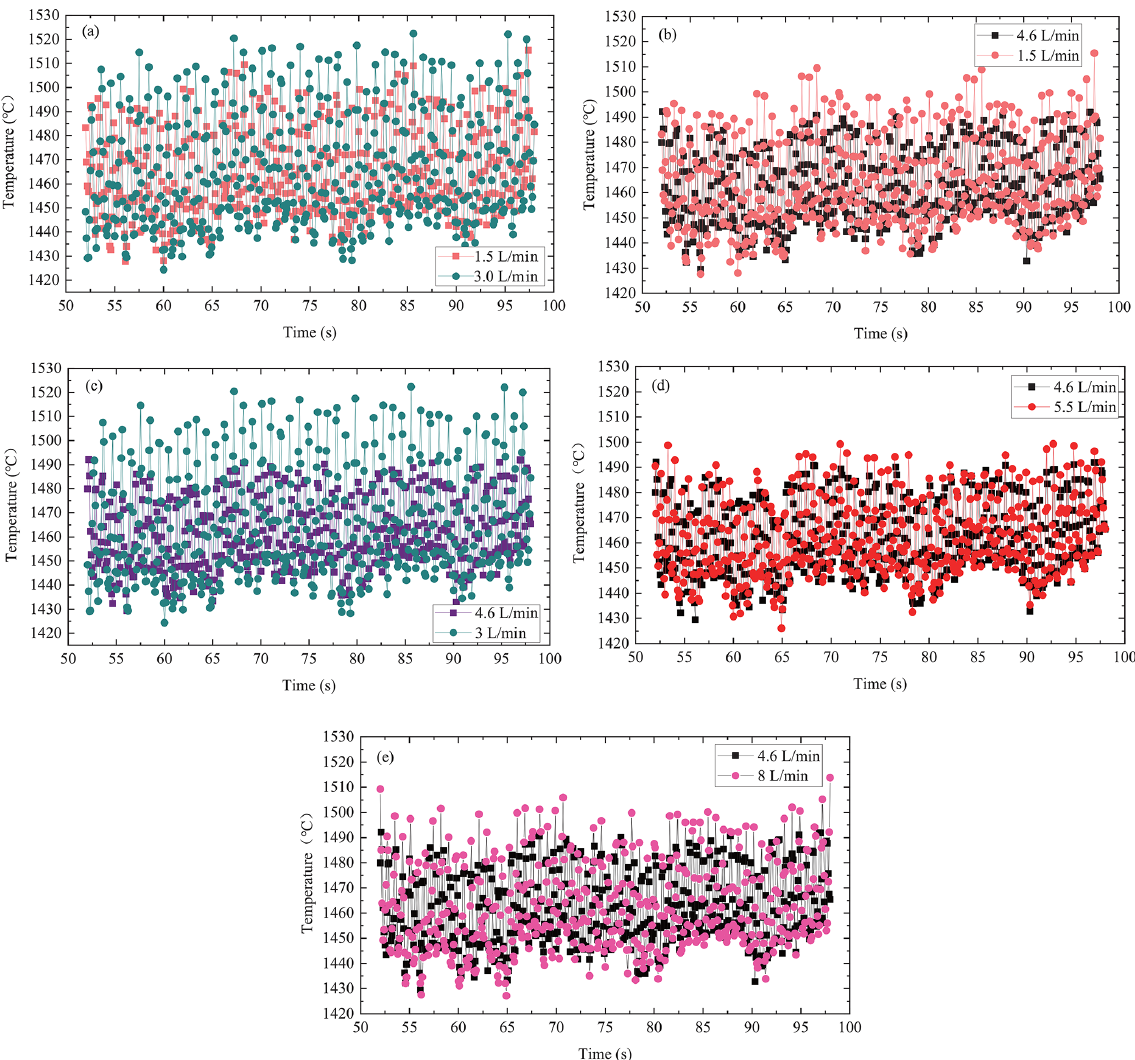
Figure 13. Temperature comparison of the welding of the micro-section at different flow rates. Table 2. The chemical composition of the base metal and welding wire of the experiment (weight percentage; wt%).